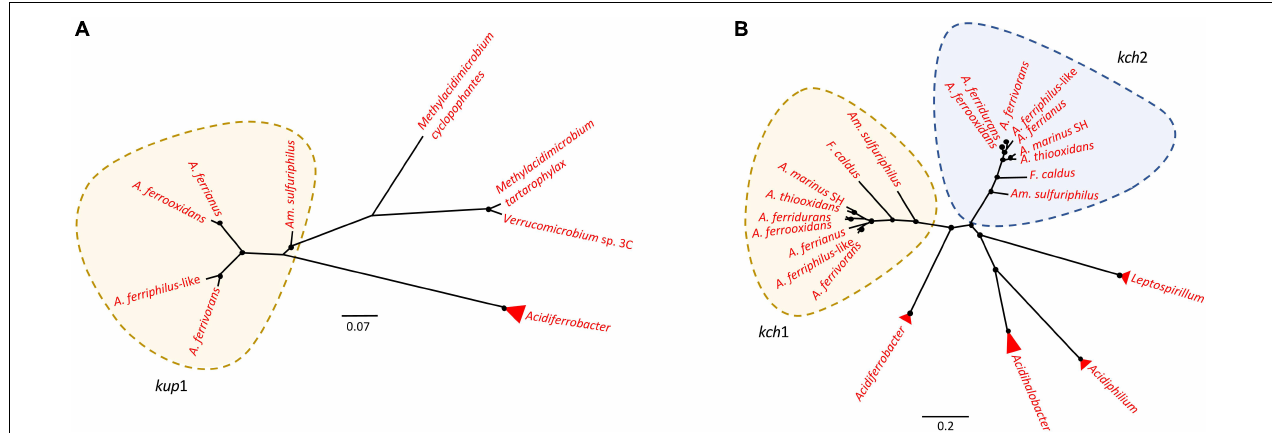
FIGURE 5 | Unrooted phylogenetic tree of potassium transporters in Acidithiobacillia and their best hits in NCBI. (A) kup gene coding for Kup system had the highest similarity to homologs in extreme acidophiles Acidiferrobacter , Methylacidimicrobium , and Verrucomicrobium . (B) kch coding for Kch system had the highest similarity to Kch homologs in acidophiles Leptospirillum , Acidiphilium , Acidihalobacter , and Acidiferrobacter . Acidophilic sequences are highlighted in red. Filled circles at nodes represent bootstrap support of ≥ 60%. The scale bar represents amino acid substitution per site.